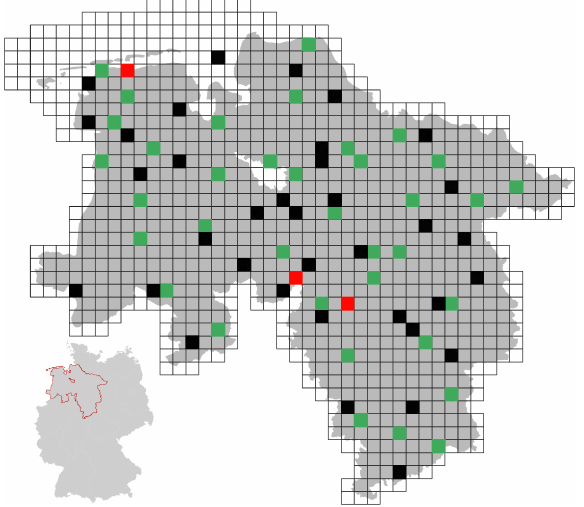
Figure 2. Overview of the available BE-8 tiles of 8 × 8 km 2 each. Grey / green: potential training / validation tiles. Red: test tiles with manually corrected reference (dataset R 1 ). Black: test tiles without corrected reference (dataset R 2 ).